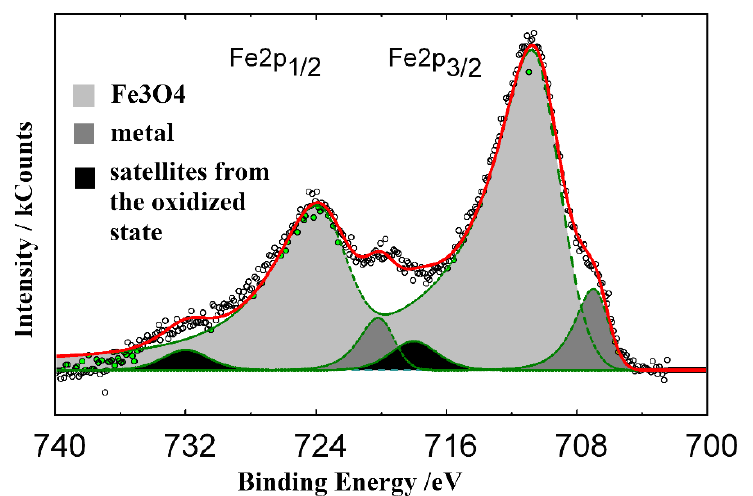
Figure 9. Standard XPS spectrum of Fe2p electrons (spin orbital splitting—doublet) of steel surface after preliminary inhibitor adsorption (2.0 M HCl + 5.0 mmol TA, 25 °C, 24 h).